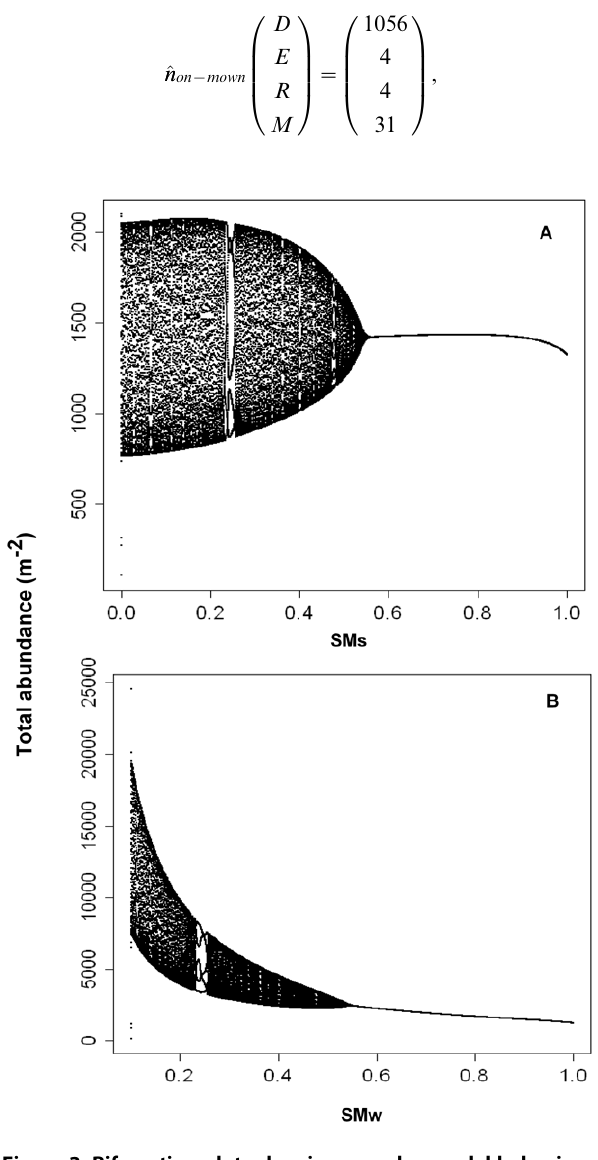
Figure 3. Bifurcation plots showing complex model behaviour: (A) summer survival ( S Ms ), and (B) winter survival ( S Mw ) of adult plants under existing mowing pattern and non- subsidised, local recruitment. X axis represents the whole parameter range from 0 to 1 and Y axis indicates the total abundance (m 2 2 ) of all the different demographic stages [i.e. seeds, seedlings, rosettes, and adult